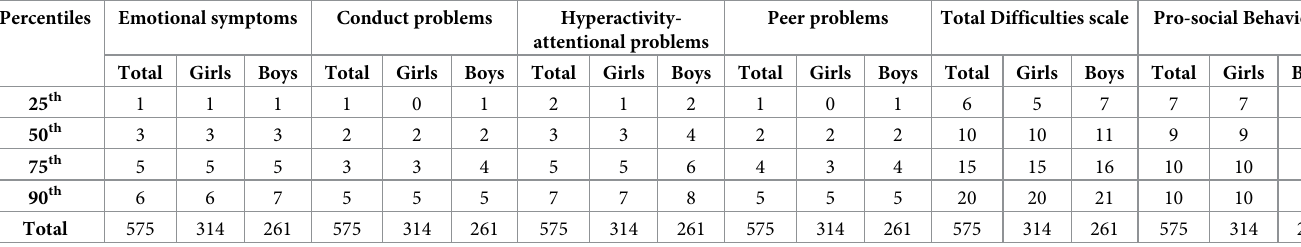
Table 10. Normative data for total scores by sex based on parental report, age group